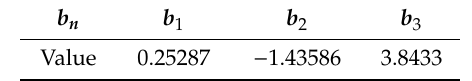
Table 6. Experimental constants in n ( ε ) .